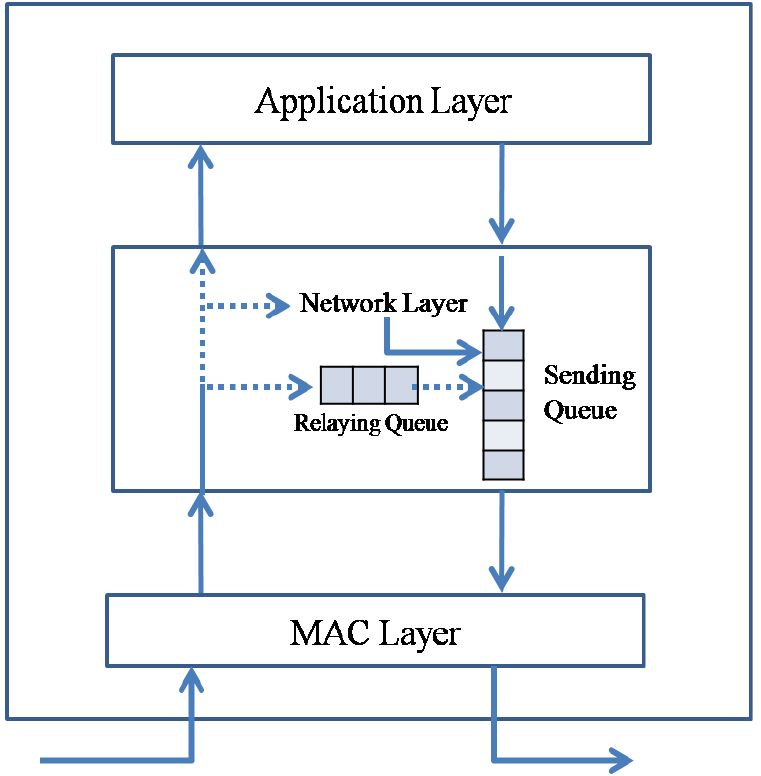
Figure 2. Packet flow in a sensor